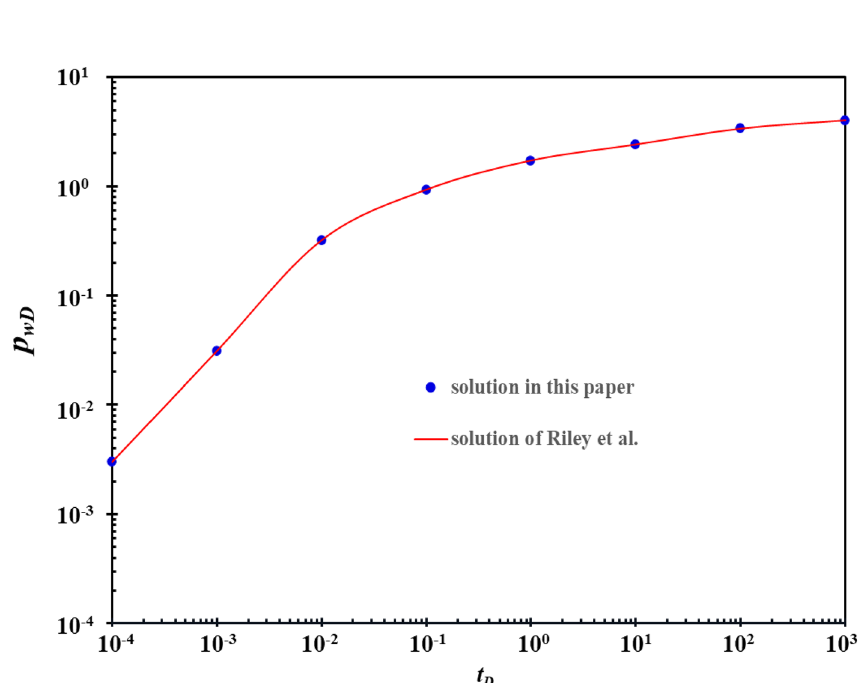
Figure 6. Comparison of calculation